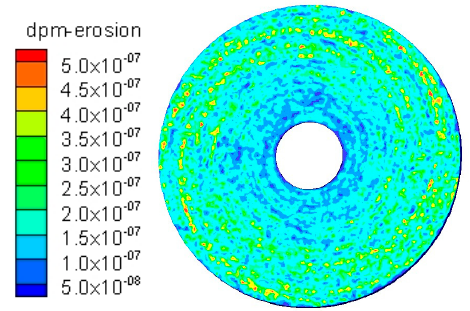
Figure 8. Wear on the surface of the rotating disc.